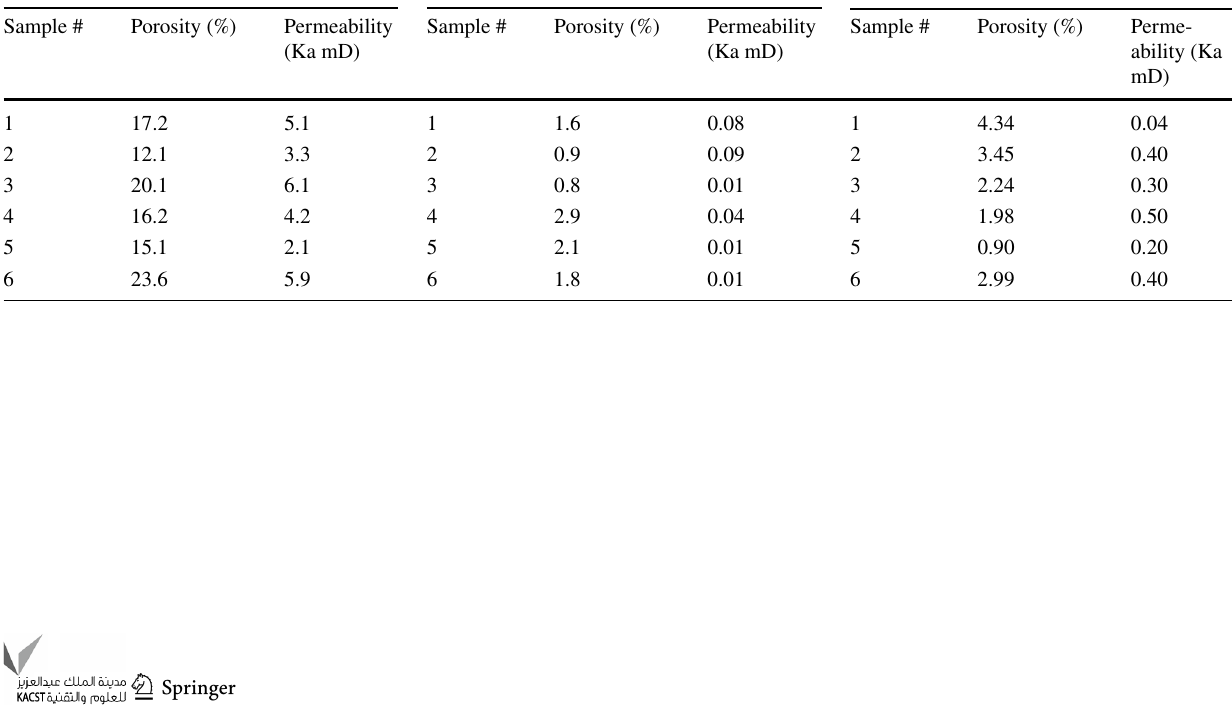
Table 4 Quantitative plug porosity and permeability analyses of the Jurassic Datta, Shinawari, and Samana Suk formations Datta